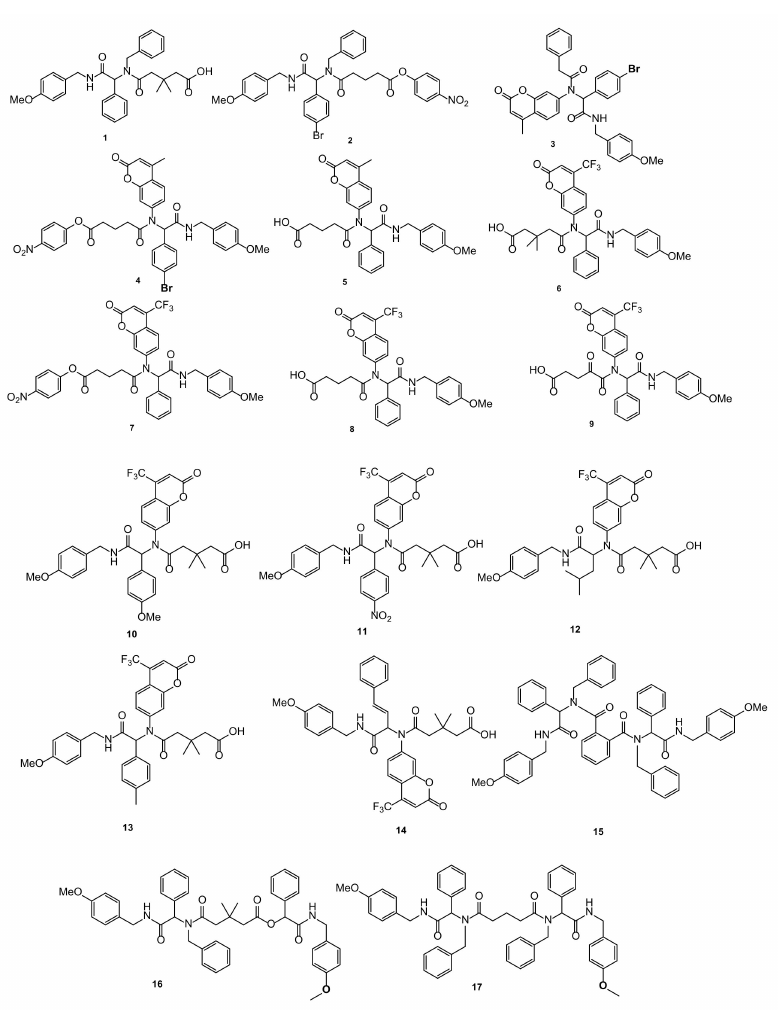
Figure 2. Structure of investigated peptidomimetics (in parentheses are given the corresponding numbering used during chemical syntheses).